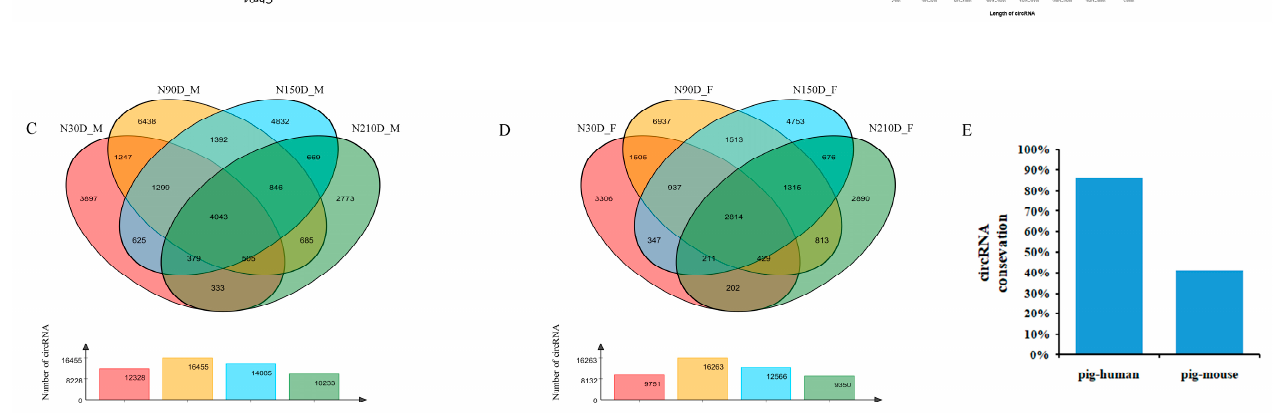
Figure 1. Identification and feature of circRNAs in Ningxiang pig. ( A ) Distribution of circRNAs in each chromosome. ( B )